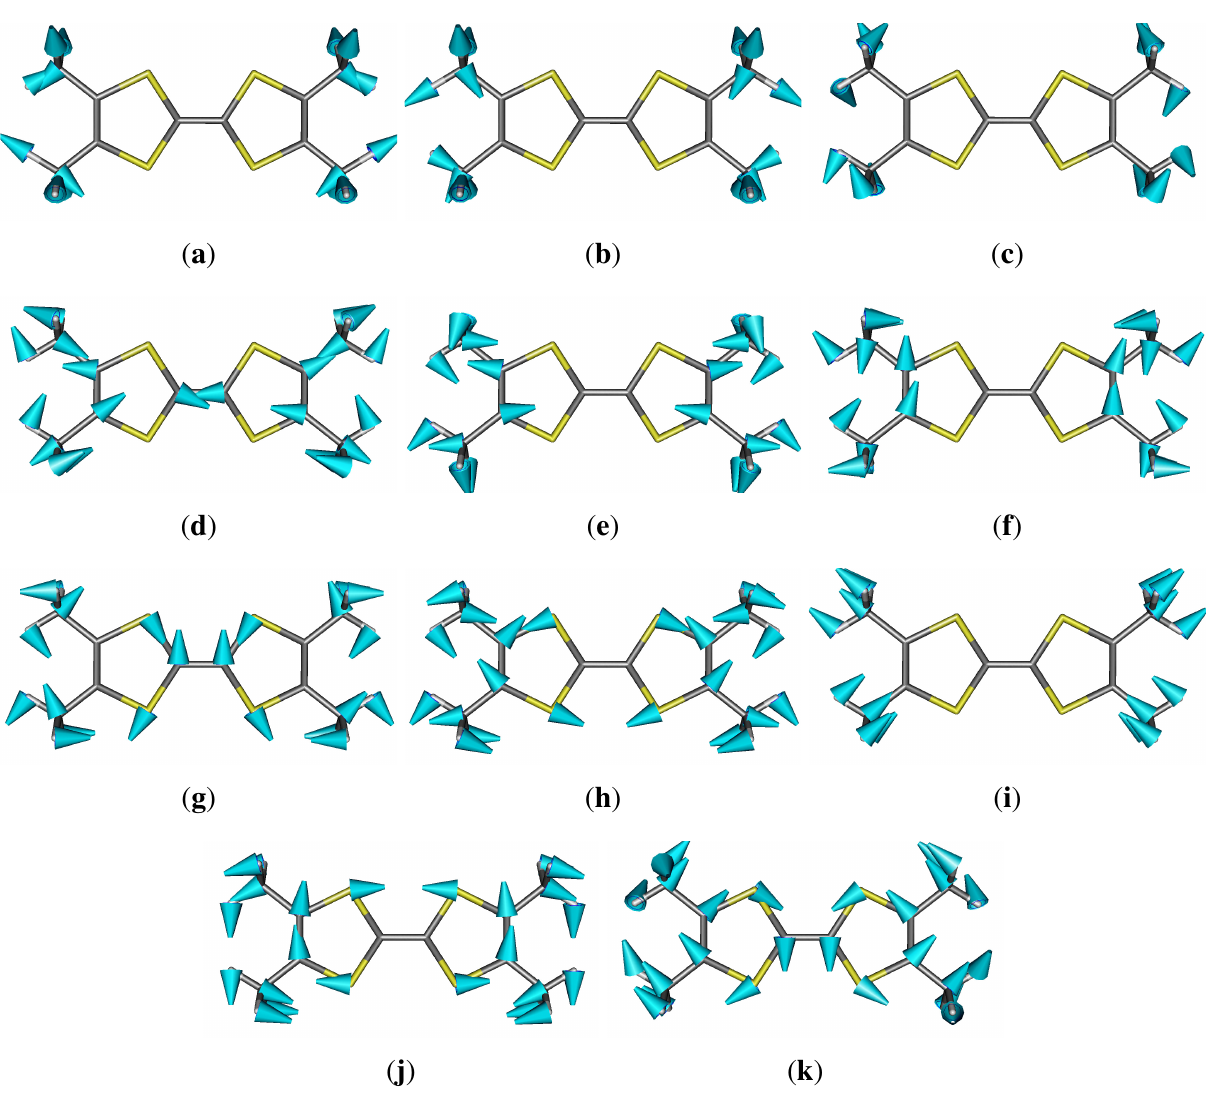
Figure A4. Eigenvectors of the eleven ungerade ( b ( b ) mode; ( b ) ν ( a ) ν 44 2 u ( b ) mode; ( g ) ν mode; ( f ) ν 49 2 u ( b ) mode. mode; ( k ) ν 54 2 u